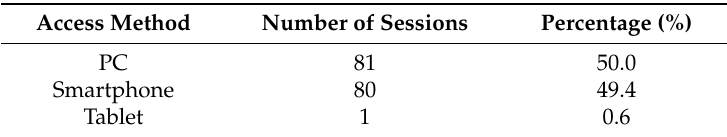
Table 2. Access Table 2. Access methods.